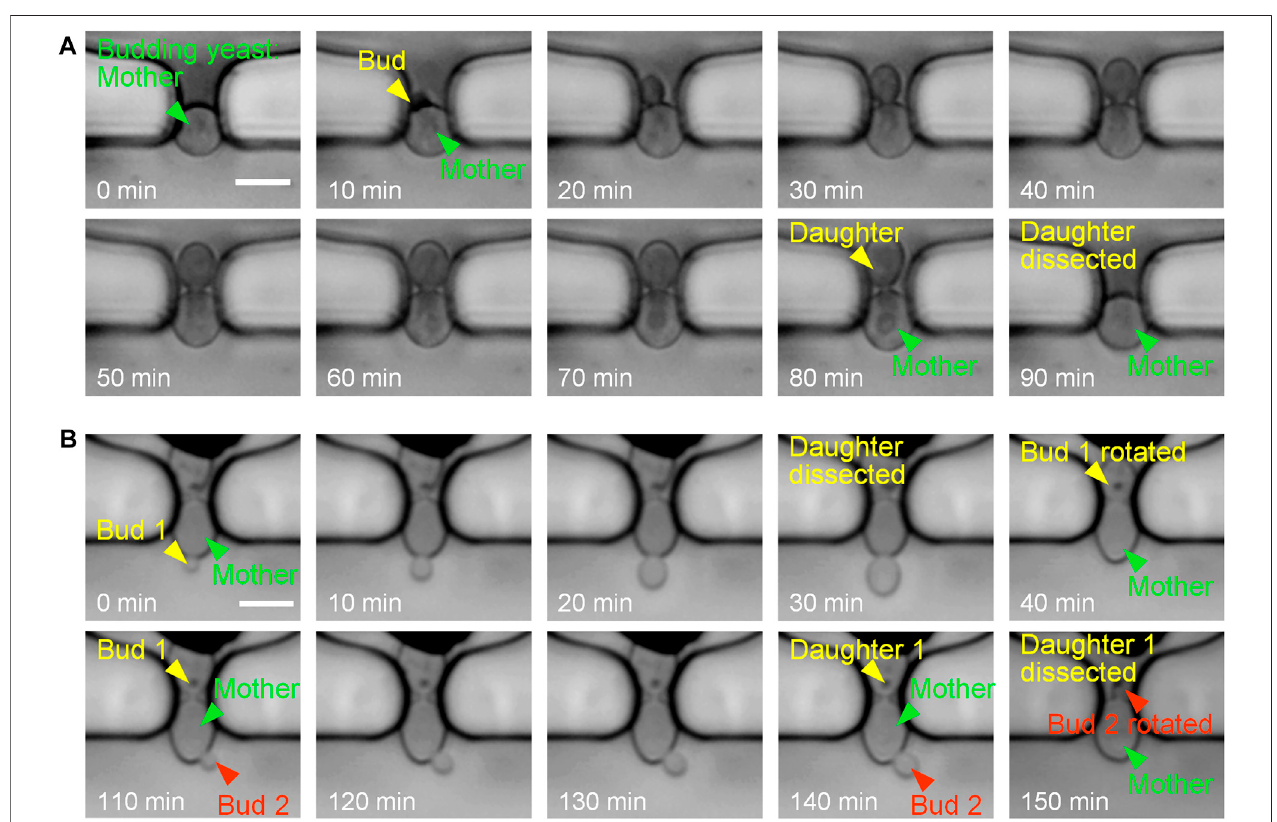
FIGURE3| Time-lapseimagesat10-minintervalsofsinglebuddingyeastcellsduringcontinuousculturing. (A) Buddinganddaughterdissectionofanimmobilized yeastcellinonegeneration. (B) Buddinganddaughterdissectionsofanimmobilizedyeastcellintwogenerationswithsuccessfulreorientationofnewbornbudstowards the side channel by fl owing fl uid. Scale bar is 4 μ